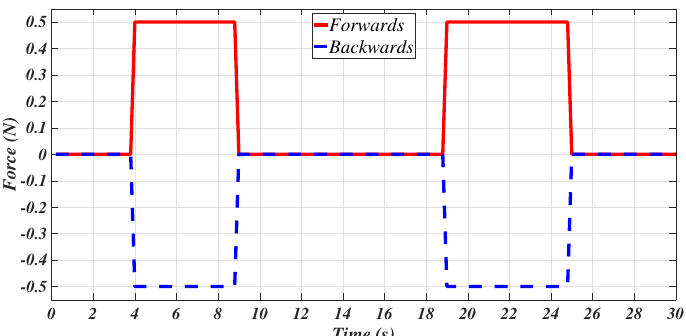
Figure 3. Programmed forces to generate the movement of the mini-AUV along b x